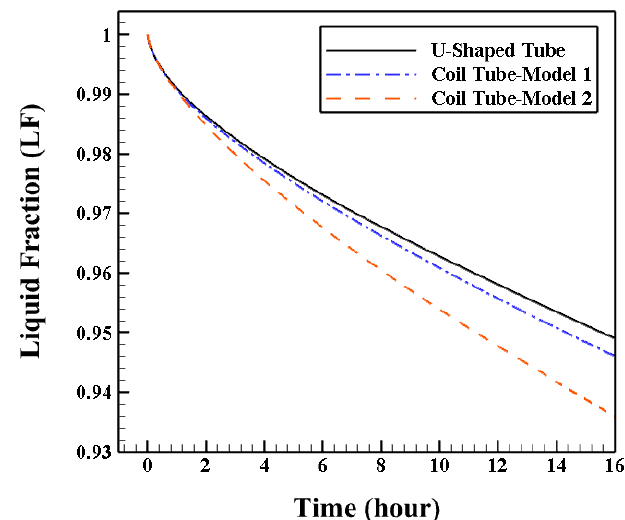
Figure 7. Temporal evolution of the liquid fraction for three types of tubes in the ice on the coil ice storage system in the horizontal position.